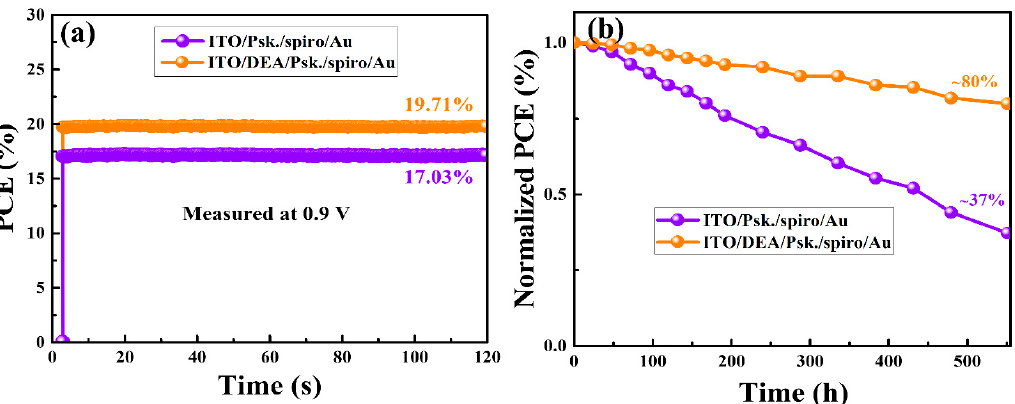
Figure 8. Stability analyses of the PSCs prepared with ITO substrates and ITO/DEA substrates. PCE at maximum power point tracking under continuous illumination of AM 1.5 G irradiation ( a ) and Normalized PCE for 550 h under AM 1.5 G irradiation ( b ).